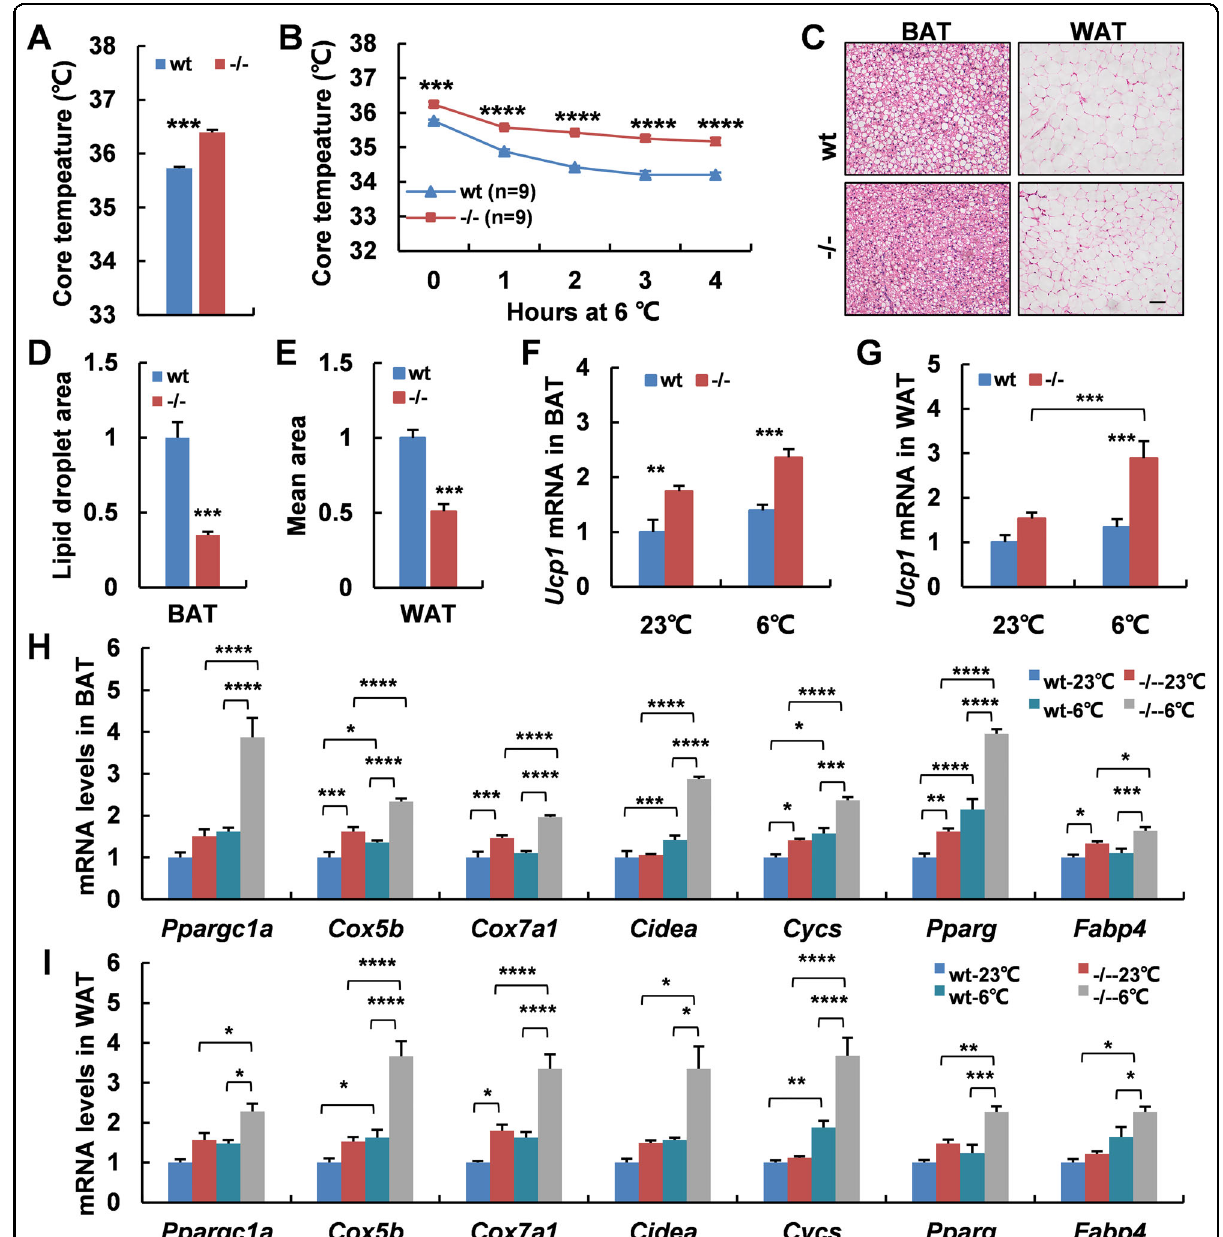
Fig. 4 Adaptive thermogenesis is increased in Adgra1 − / − male mice. A Rectal temperature of Adgra1 − / − male and control mice, n = 9/group. B Rectal temperature of Adgra1 − / − male and control mice when they are exposed to cold (6 °C) for 4 h, n = 9/group. C Representative images of HE stained BAT, and WAT from Adgra1 − / − male and control mice in cold environment. Scale bar, 50 μ m, n = 5/group. D Quantify of the lipid droplet- positive area in the BAT, n = 5/group. E Quantify of the mean area of the adipocytes in the WAT, n = 5/group. F Ucp1 mRNA levels of BAT in room temperature and cold environment, n = 5/group. G Ucp1 mRNA levels of WAT in room temperature and cold environment, n = 5/group. H mRNA levels of thermogenic genes of BAT in room temperature and cold environment, n = 5/group. I mRNA levels of thermogenic genes of WAT in room temperature and cold environment, n = 5/group. * p < 0.05, ** p < 0.01, *** p < 0.001, **** p < 0.0001 vs. controls. Data represent mean ±